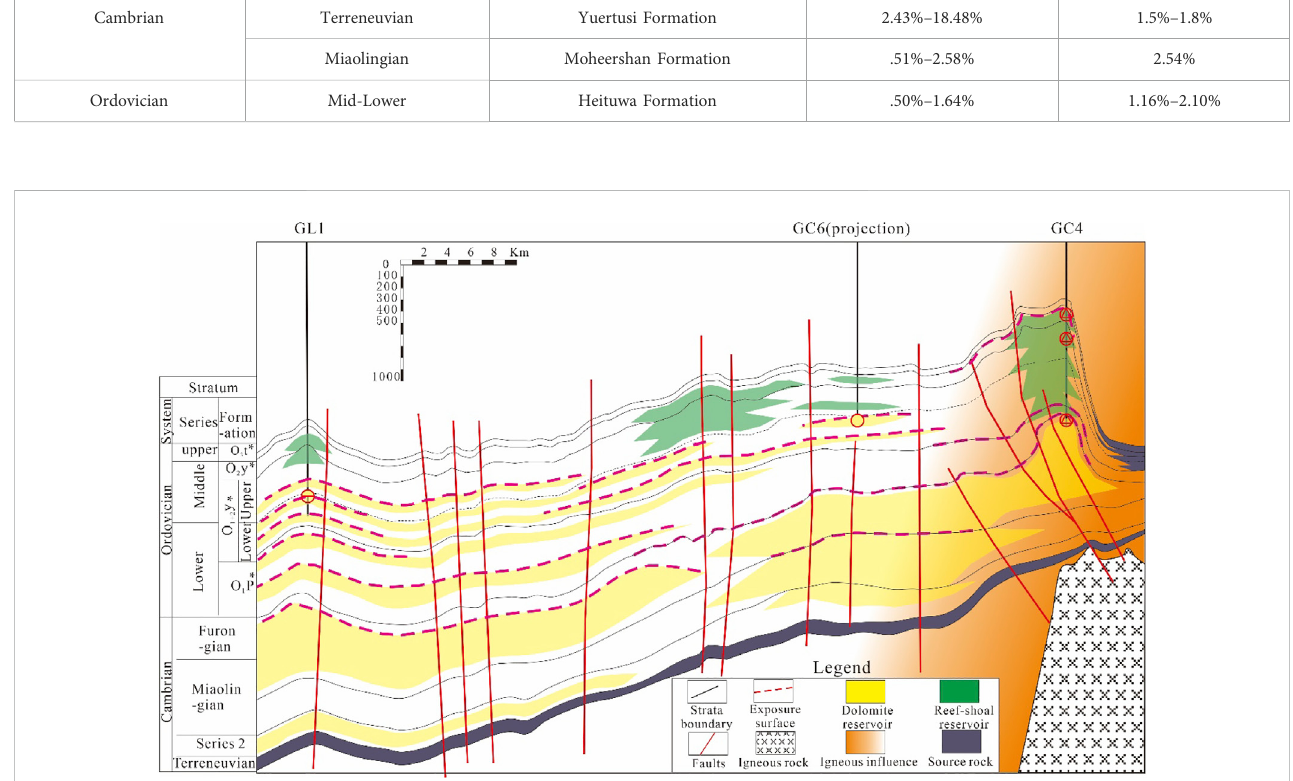
FIGURE 3 Pathway system composed of vertical faults and lateral unconformities in the Gucheng area. (Section location, AA ′ , is shown in Figure